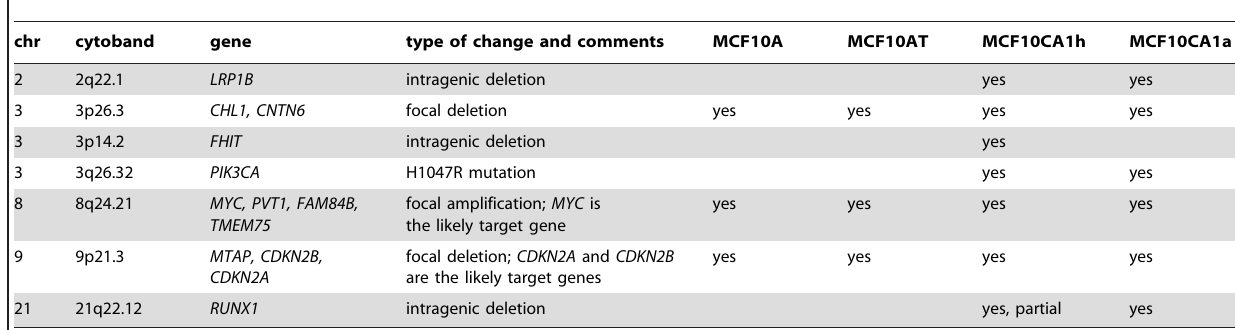
Table 1. Focal amplification and intragenic deletion and mutation in the MCF10 series cell lines.